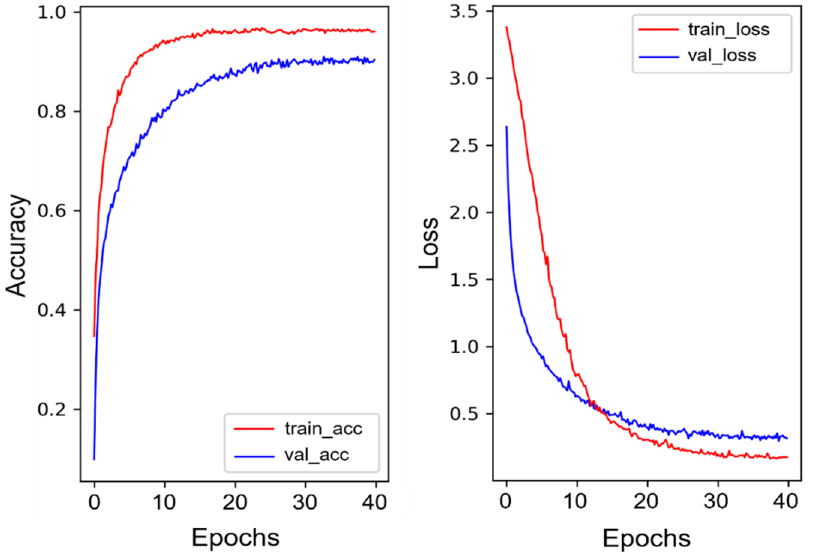
Figure 5. Training and validation accuracy/loss performance of the fine-tuned RegNet model on Fold 5. Table 3. Performance of the proposed manipulated face image identification model compared to the other models. The best performance for each metric is highlighted in bold.